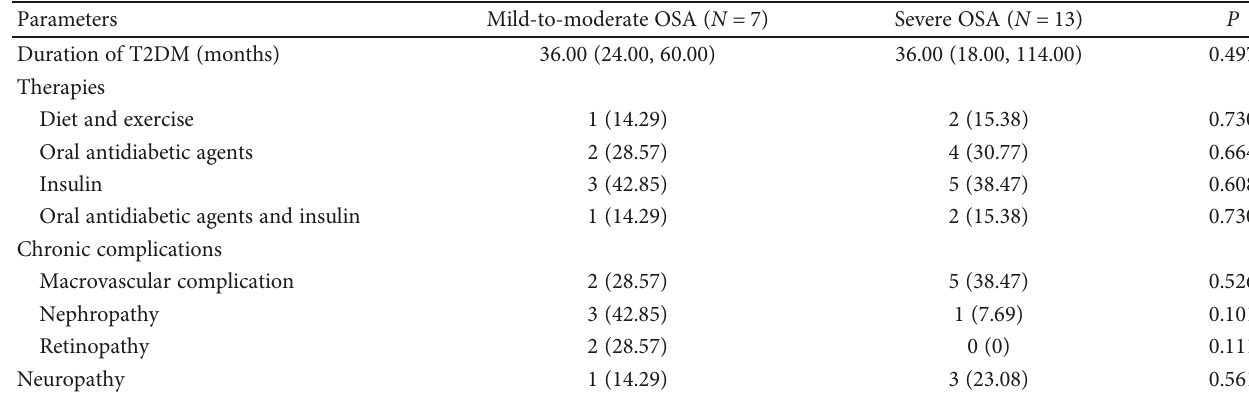
Table 3: Baseline characteristics of